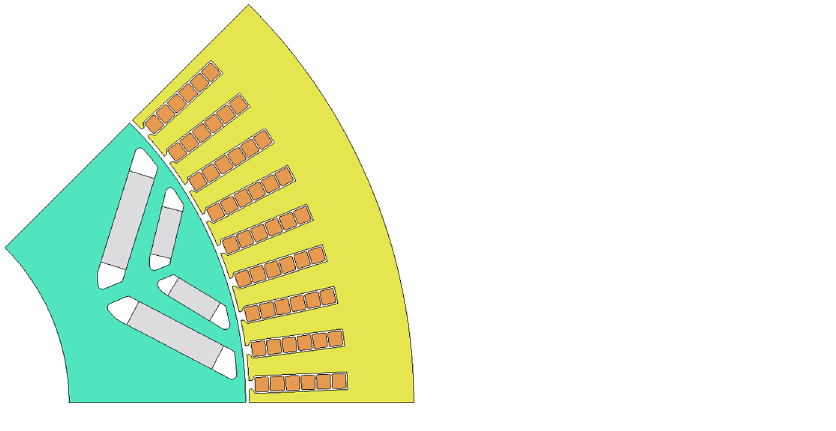
Figure 11. Cross section of the IPM model with three SPP values and six conductors. Table 3. Design parameters for the baseline IPM machines.